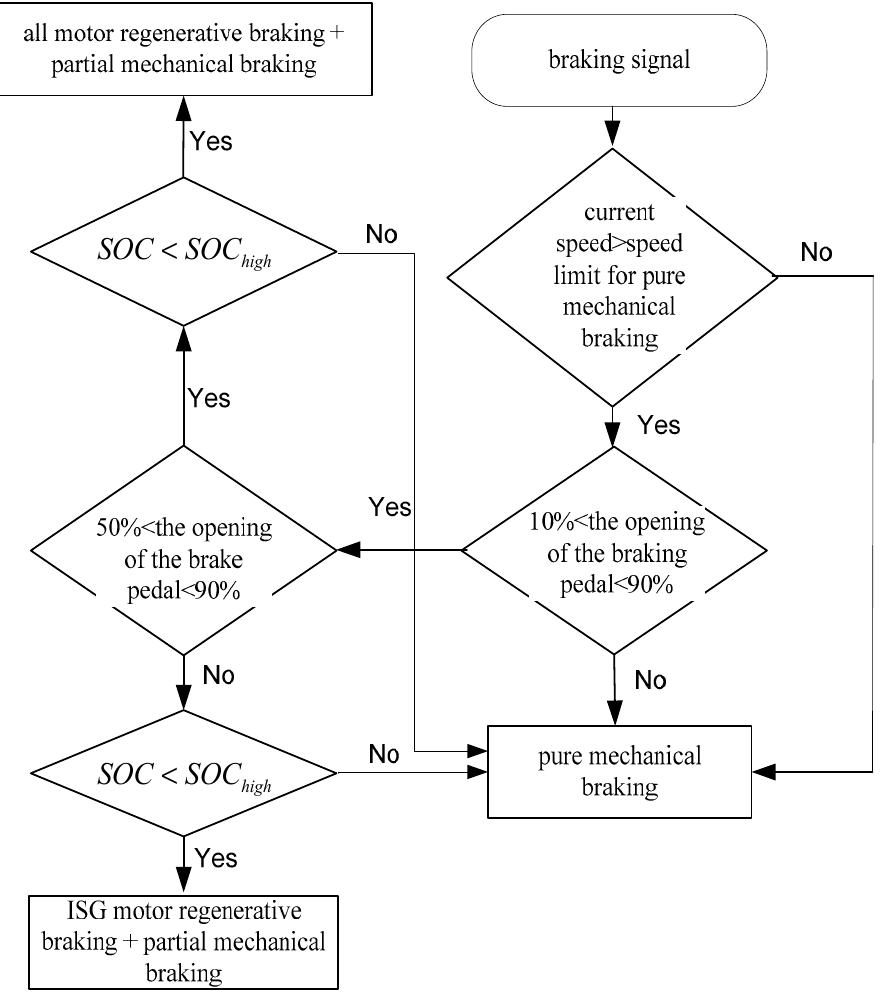
Figure 13. Control logic flow diagram of braking mode. Table 9. Key parameters of logic threshold energy management strategy.